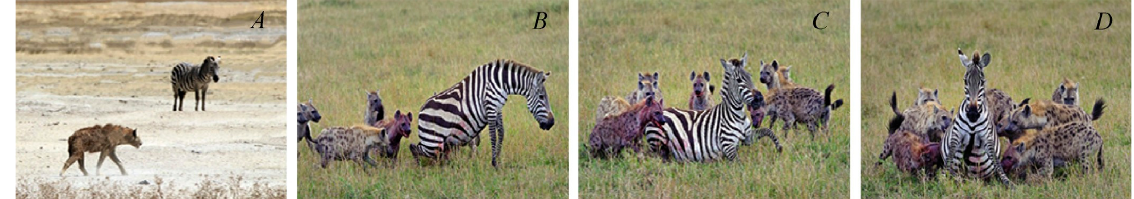
Figure 3. Various phases of spotted hyena hunting behavior: ( A ) searching and tracking prey; ( B ) chasing; ( C ) troublesome and encircling; ( D ) immobilize situation and attack prey [31].